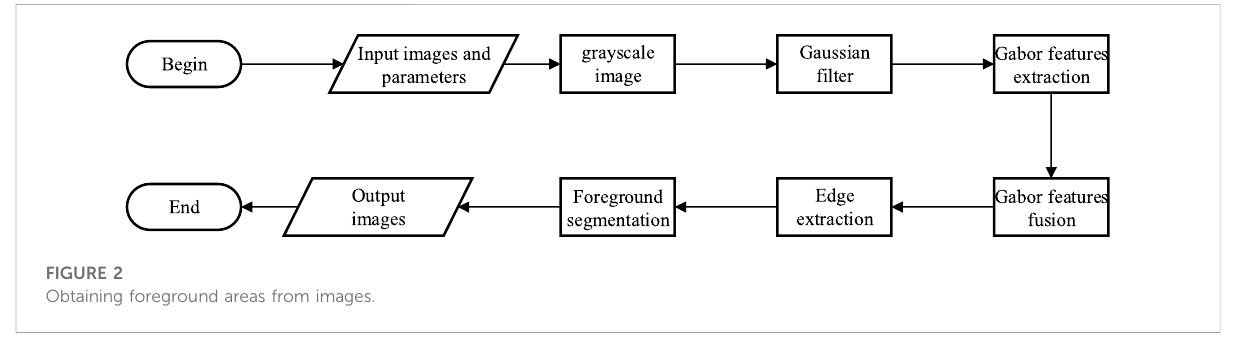
FIGURE 2 Obtaining foreground areas from